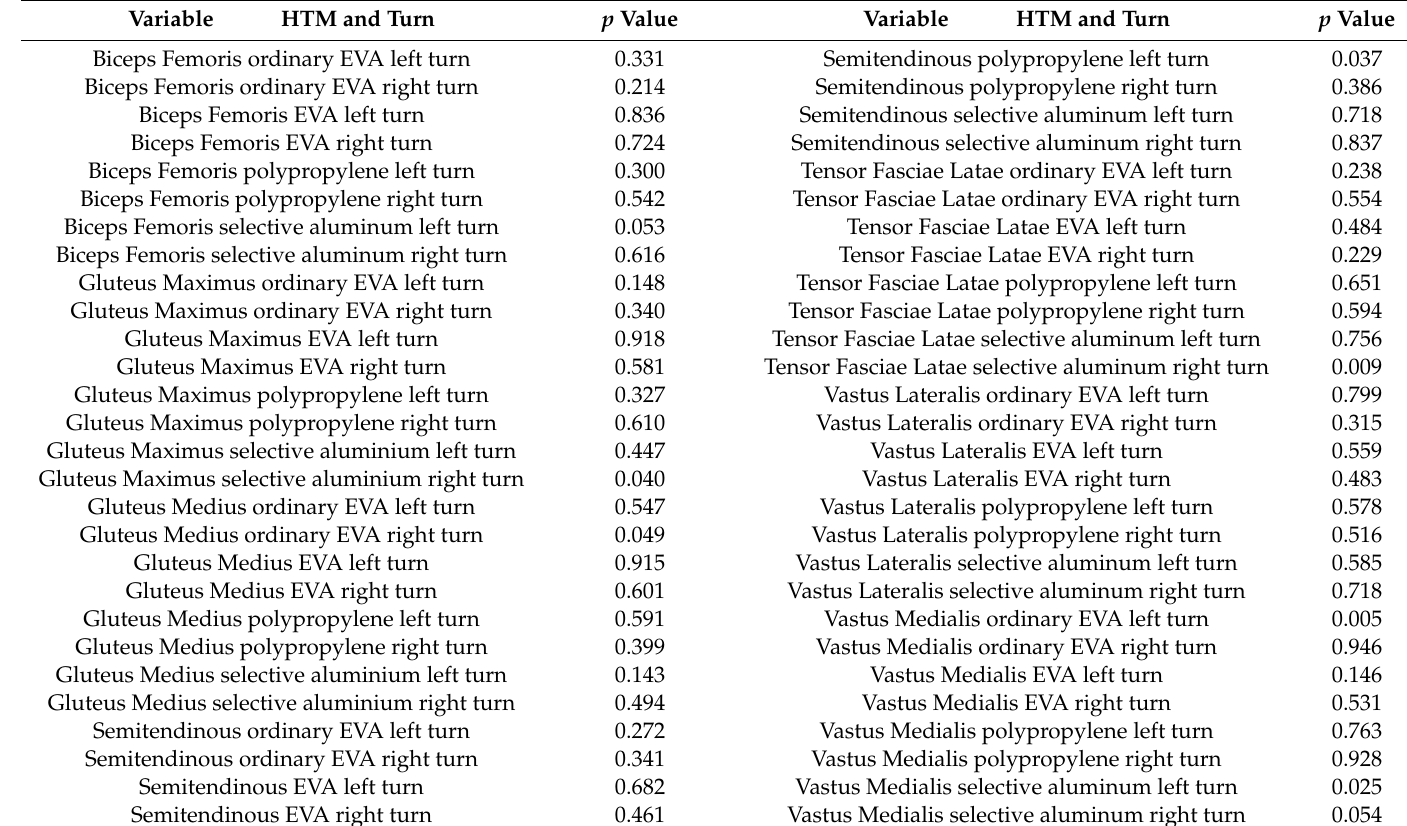
Table 2. Normality test of the EMG variables of the thigh and hip muscles for di ff erent